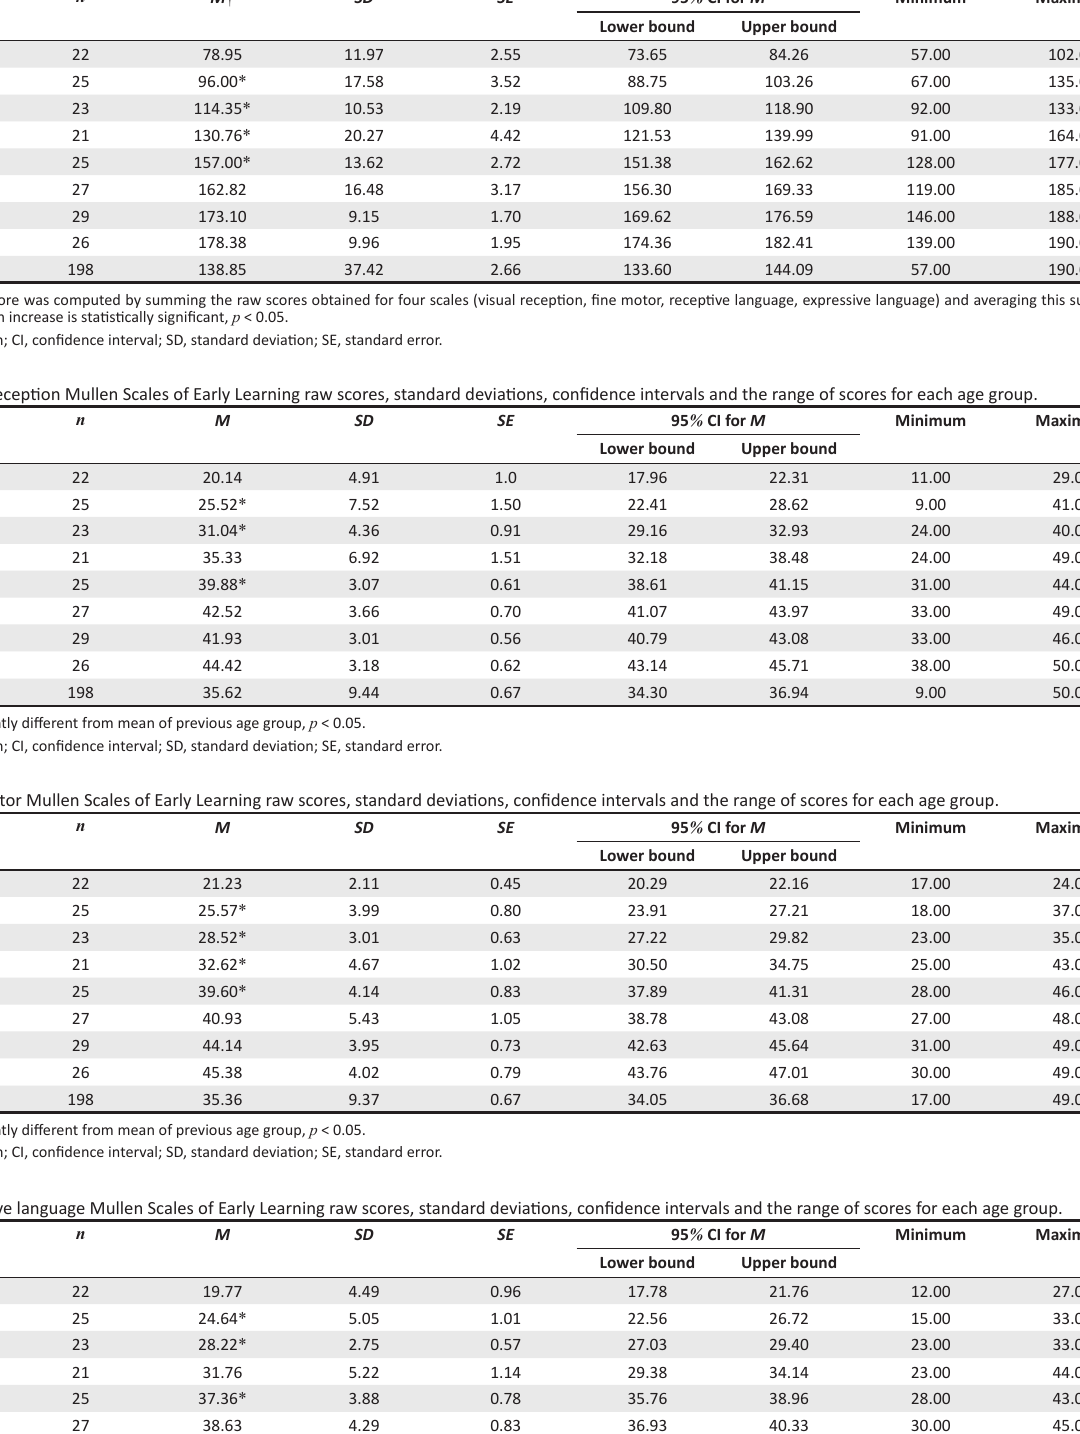
TABLE 4: Mean total Mullen Scales of Early Learning raw scores, standard deviations, confidence intervals and the range of scores for each age group. Age (in months) n M † SD SE 95 % CI for M Minimum Maximum Lower bound